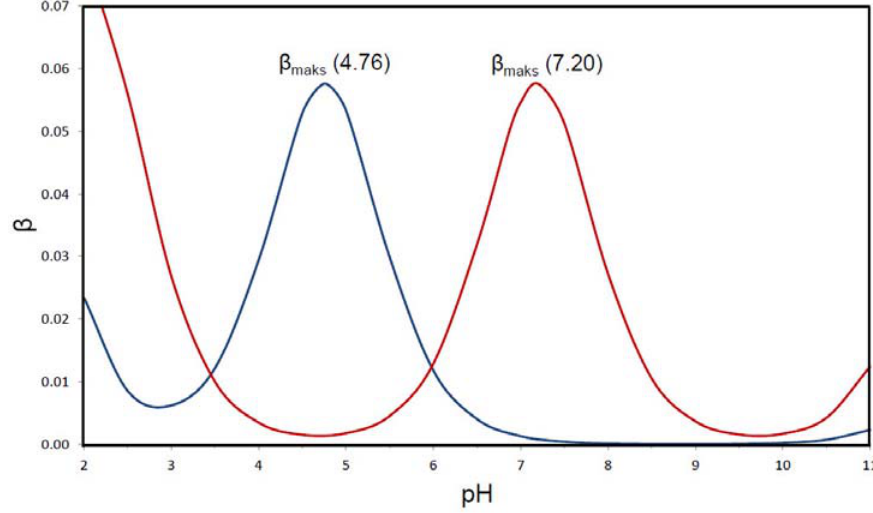
maximal buffering strength at pH 4.76 (Figure 2, curve a) and are able to keep stable pH of the mobile phase bet- ween 3.7 and 5.7. Acetate buffers are also preferred when mass spectrometric detection was combined with the LC separation.